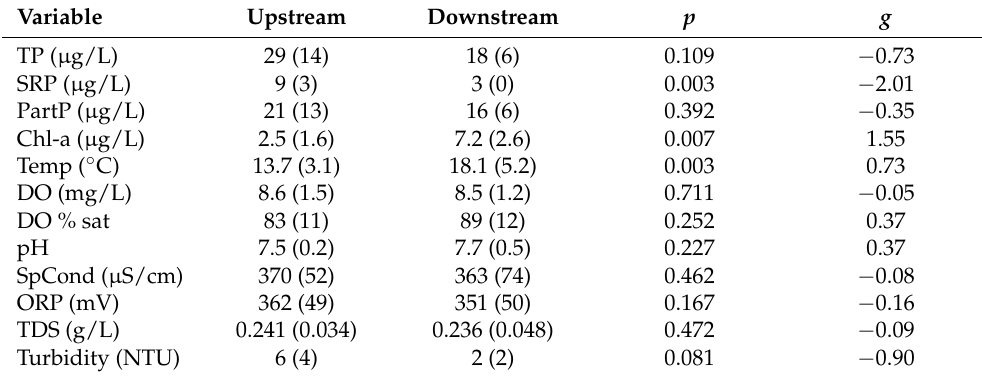
Table 3. Post-restoration (n = 7 months; May–October 2020, April 2021) upstream vs. downstream mean ( ± SD) water quality values. Statistical analyses used paired t -tests and Hedge’s g -value. Posi- tive g -values correspond to an increase in the water quality parameter when moving from upstream to downstream. TP = total phosphorus; SRP = soluble reactive phosphorus; PartP = particulate P; Chl-a = lab-extracted chlorophyll a; DO = dissolved oxygen; SpCond = specific conductivity; ORP = oxidation–reduction potential; TDS = total dissolved solids.